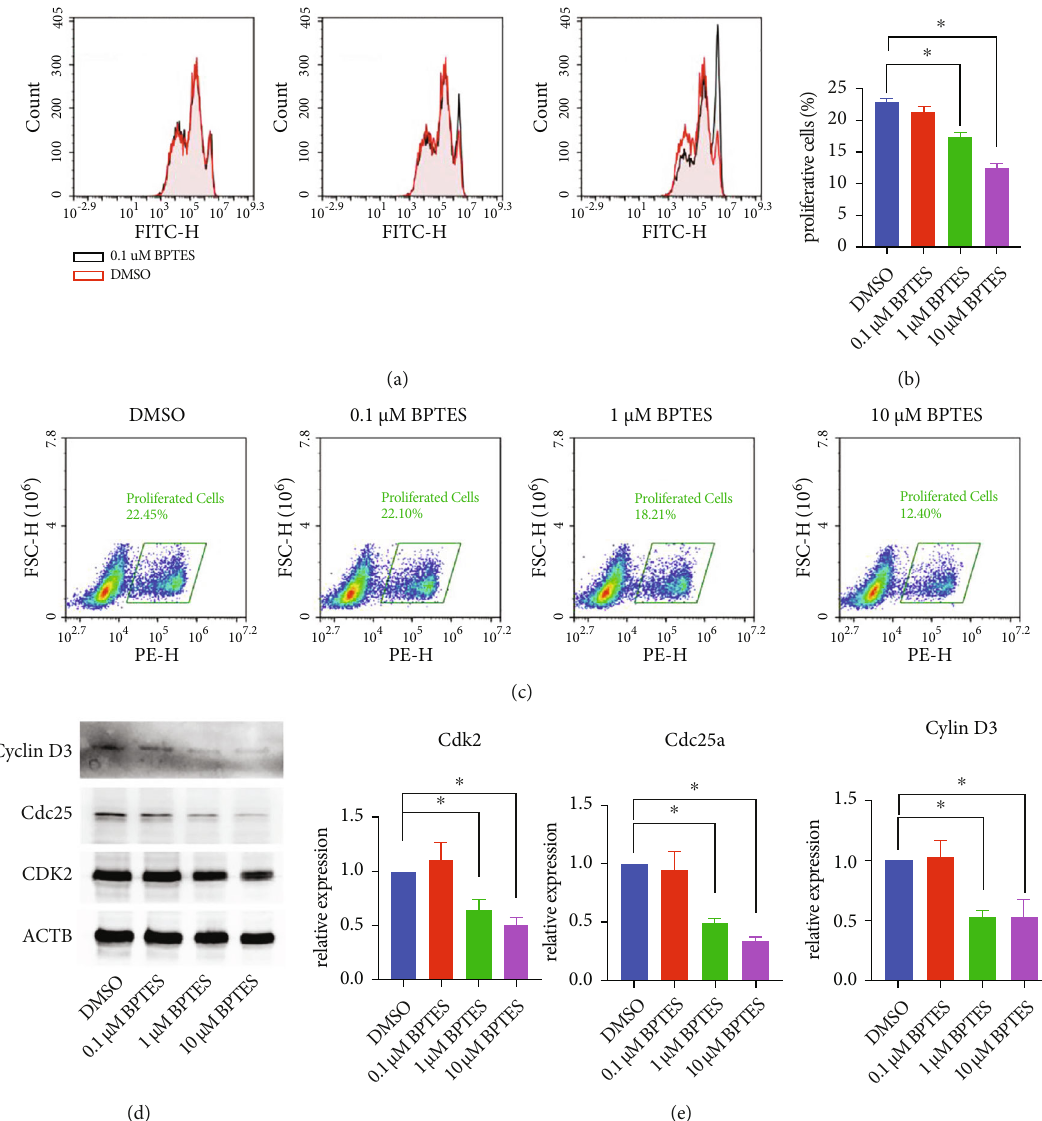
Figure 3: BPTES treatment con fi ned the proliferation of CD4+ T cells upon activation. (a) Representative fl ow cytometry images of the CFSE assay in activated CD4+ T cells treated with the indicated doses of BPTES. (b, c) Representative fl ow cytometry images and statistical analysis of the EdU assay in activated CD4+ T cells treated with di ff erent dosages of BPTES. (d) Representative Western blot pictures of Cyclin D3, Cdc25, and Cdk2 in activated CD4+ T cells treated with di ff erent doses of BPTES. (e) ImageJ quanti fi cation of the relative expression of Cyclin D3, Cdc25, and Cdk2 in activated CD4+ T cells treated with di ff erent doses of BPTES. Summary data are presented as ∗ p < 0 : 05 with unpaired two-tailed Student ’ s t